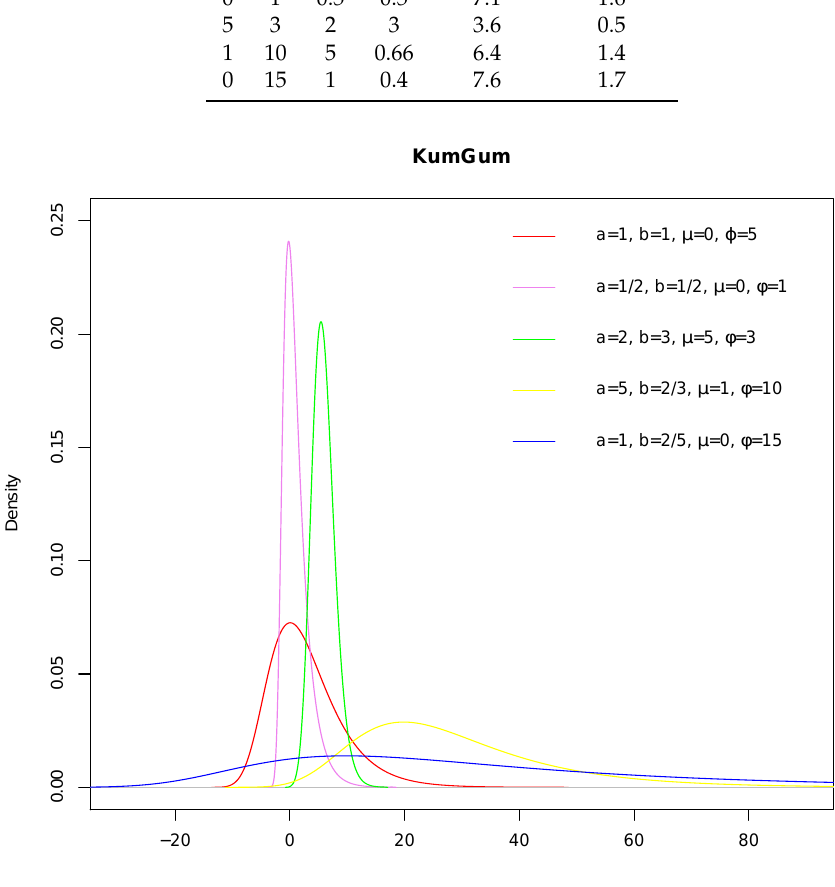
Figure 1. KumGum density